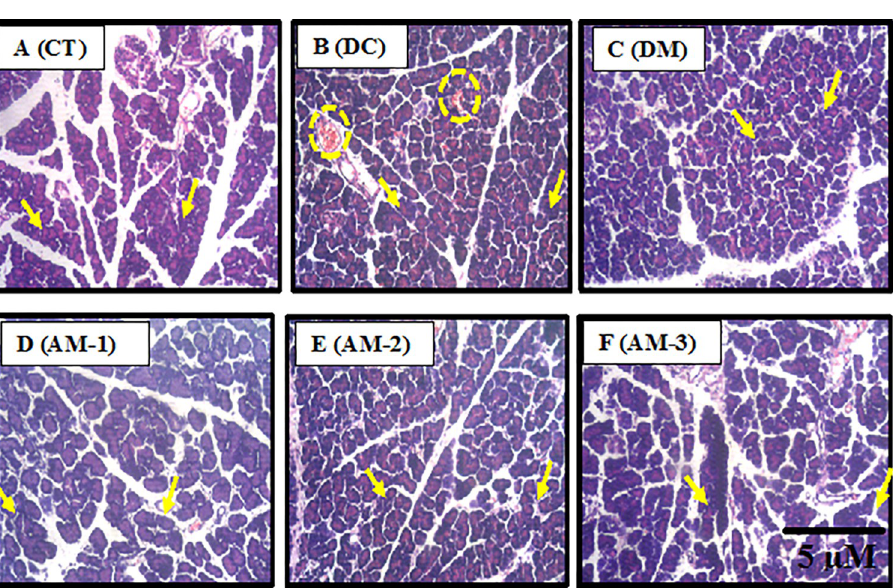
Fig 5. Cross section of the pancreas of rats after administration of aqueous extract of A . muricata peels. MG X100; H & E stain. (A) CT: control group showing normal histomorphological presentation of the islet cells with characteristic normal staining intensity. There are no histopathological alterations (yellow arrow); (B) DC: Diabetic control showing normal general histomorphological presentation with conspicuous metallic deposit (yellow circles) suggesting possible mild pathological alteration, mild infiltration of inflammatory cells; (C) DM: Diabetic metformin; (D) AM-1: Diabetic + AEAMP (6.76 mg/kg); (E) AM-2: Diabetic + AEAMP (13.53 mg/kg); (F) AM-3: Diabetic + AEAMP (27.06 mg/kg) shows the restoration of the islet of Langerhans (IL) (yellow arrows).